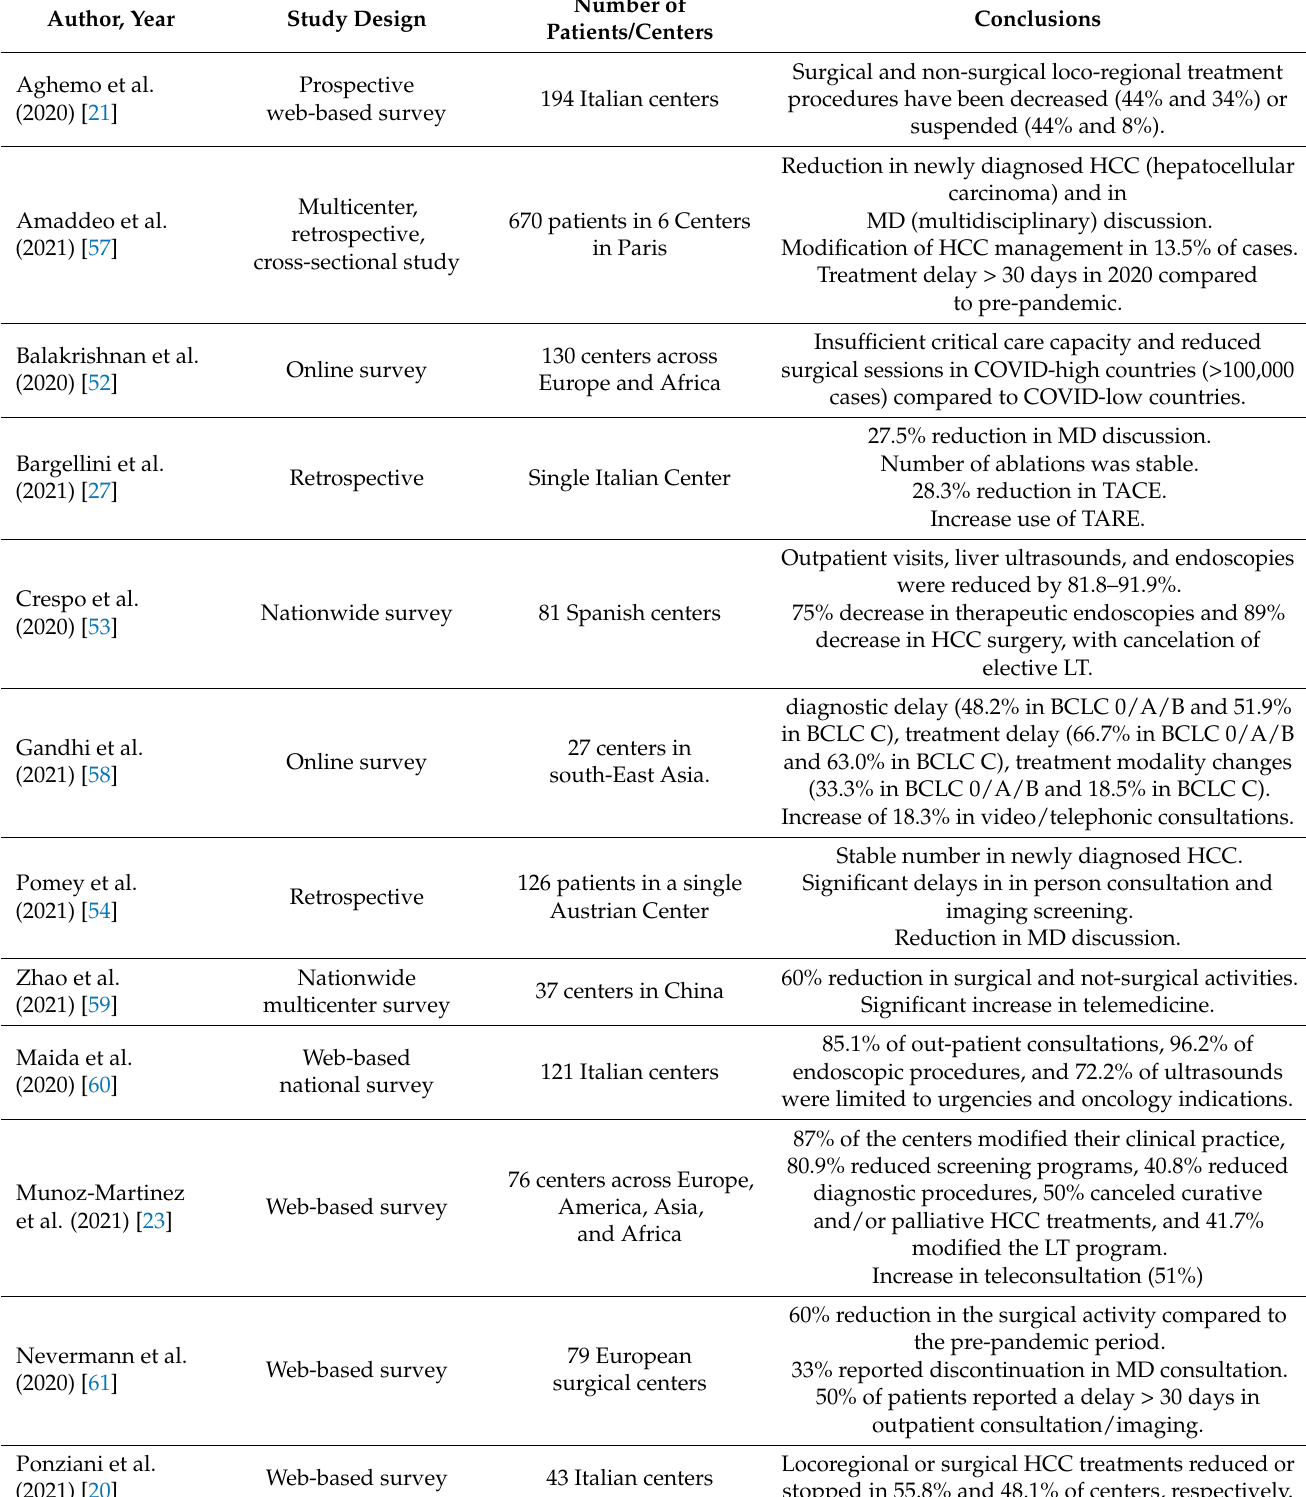
Table 2. Studies evaluating the impact of COVID-19 on HCC management and